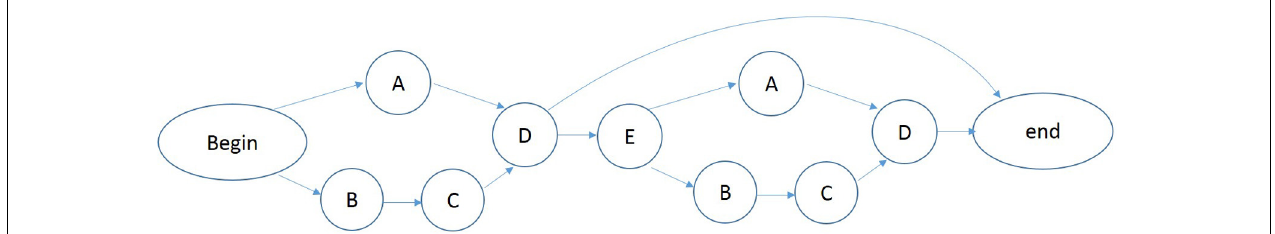
FIGURE 1 | Artificial grammar